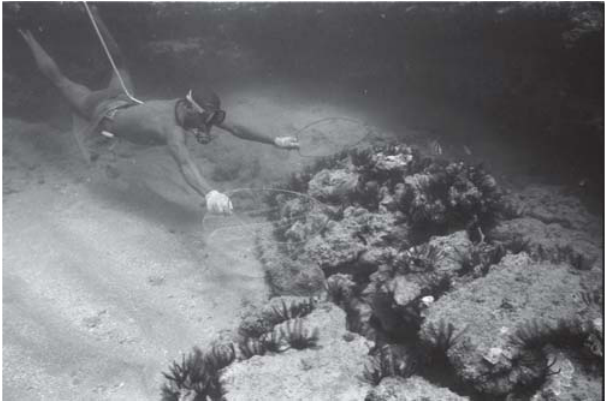
Fig. 4. Hooka-diver using hand-nets to collect marine orna- mental fishes. Baía de Todos os Santos, Bahia State, Brazil. Photo: Leo Dutra.